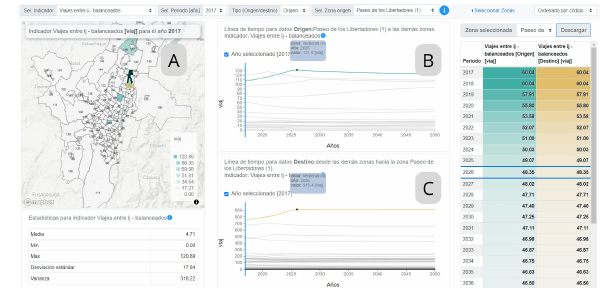
Figure 2. Inter-zone explorer tool